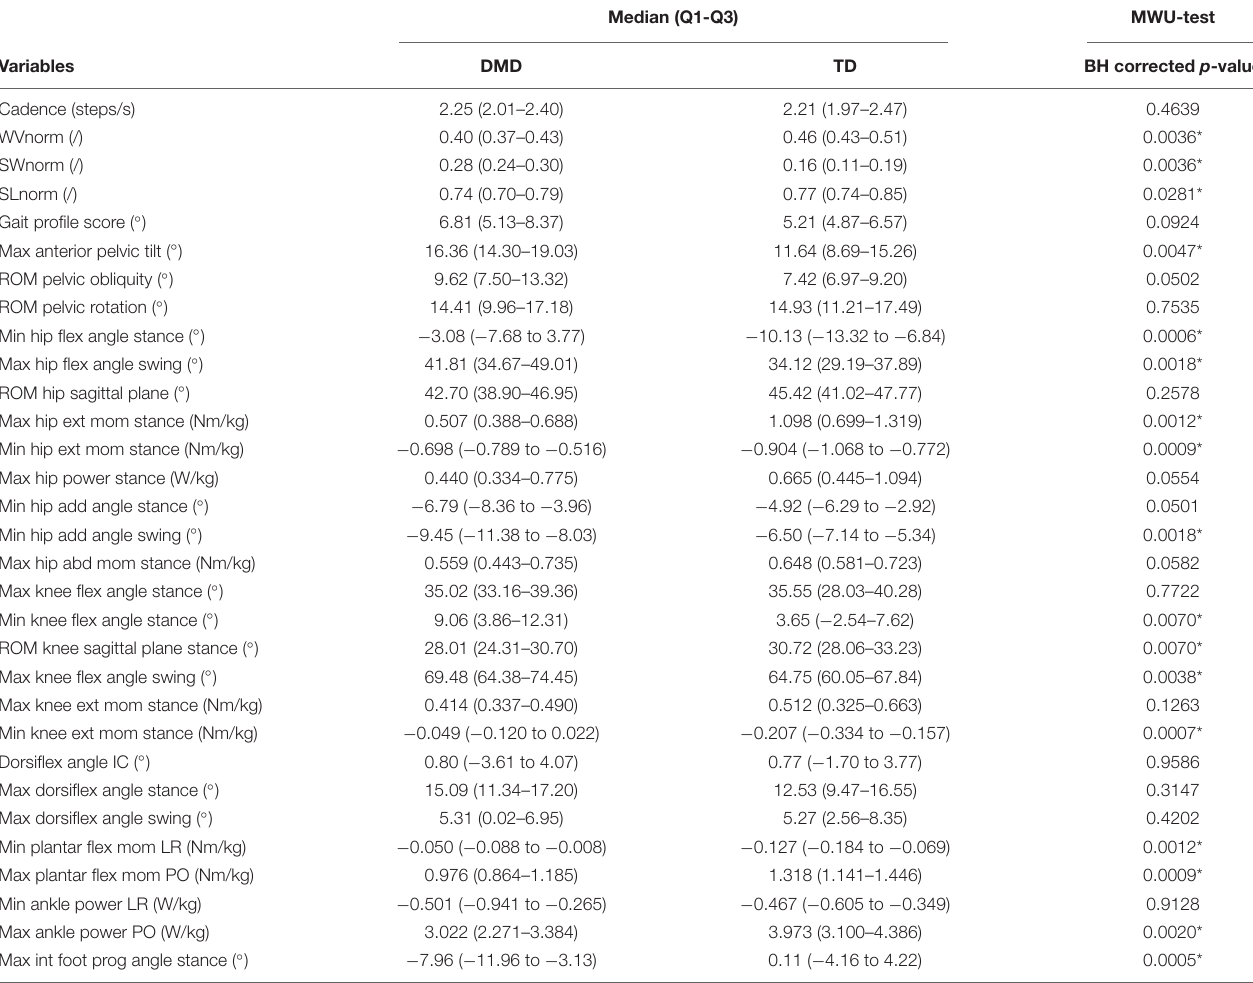
TABLE 2 | Group differences in gait features between DMD at baseline and TD, and results from MWU-test.